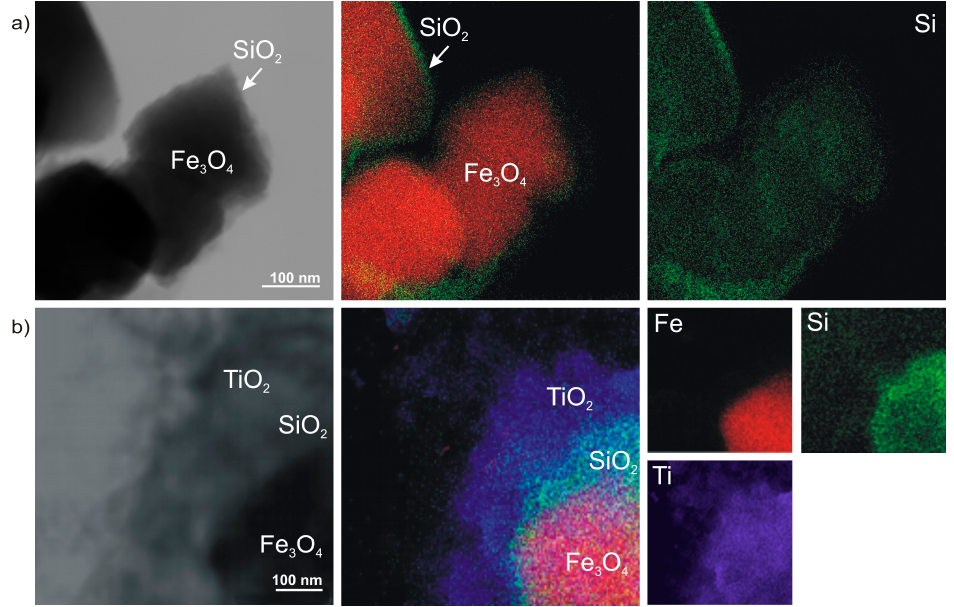
Figure 5. HAADF images of Fe 3 O 4 /SiO 2 ( a ) and Fe 3 O 4 /SiO 2 /TiO 2 ( b ) combined with mappings of Fe 3 O 4 , SiO 2 and TiO 2 (blue is Ti, red is Fe and green Si).